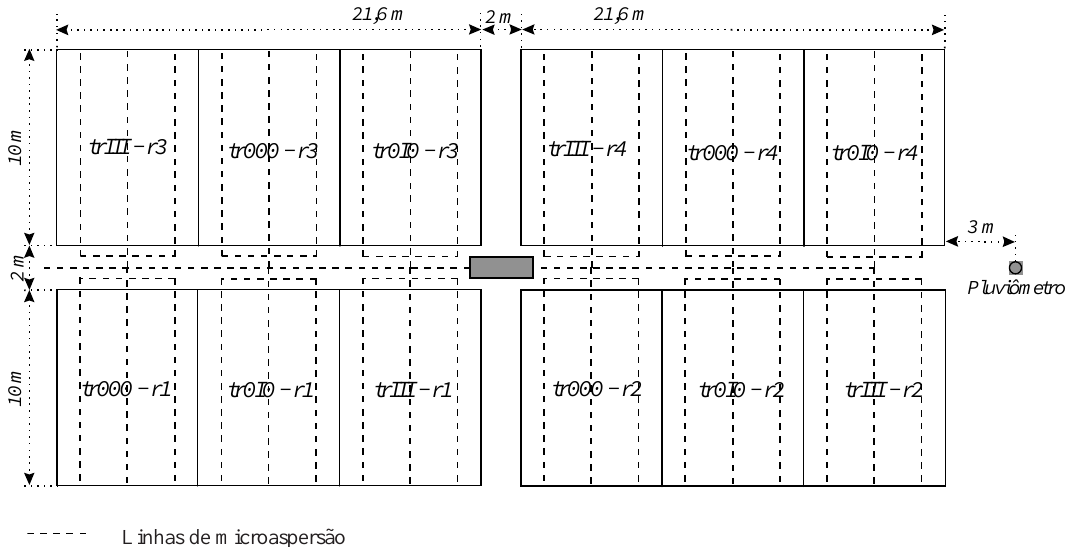
Figura 1. Esquema da área